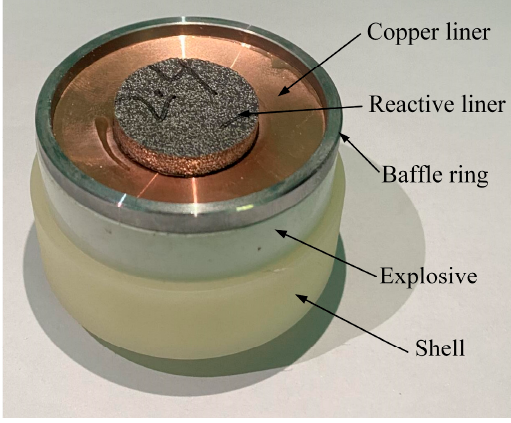
Figure 2. Structure of coated reactive EFP liner.